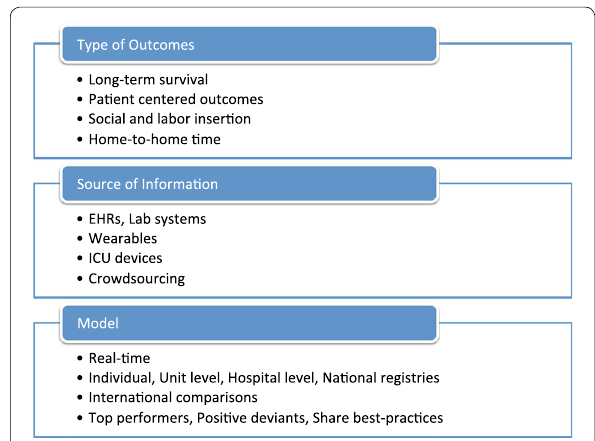
Fig. 1 The future of critical care